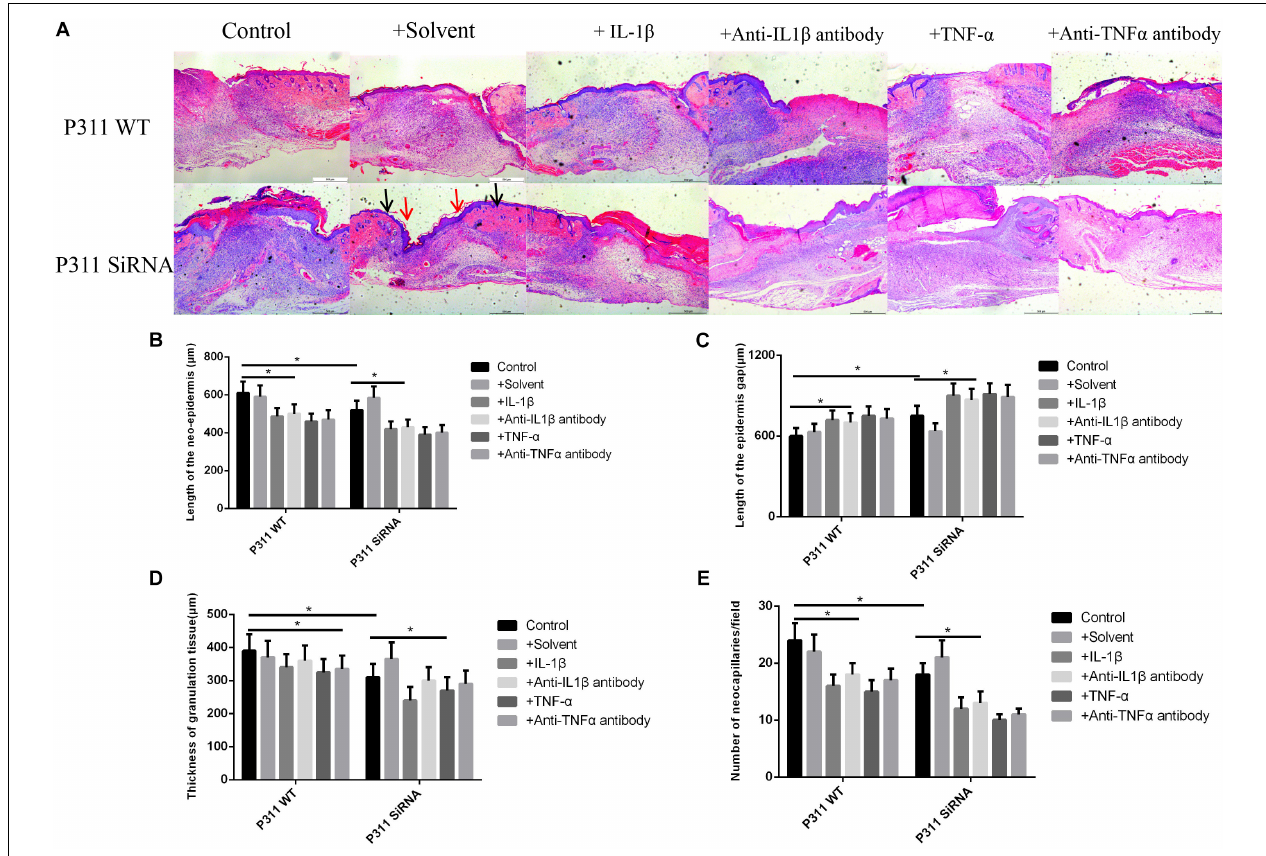
FIGURE 7 | Effect of various stimulus factors on neonatal epithelial length, granulation tissue thickness, and number of blood vessels. Mean ± standard deviation (SD) denote the experimental results; * indicates P < 0.05. (A) Representative histological images of the length of neonatal epithelium under different stimulus factors in P311 WT and P311 siRNA groups. (B) Neonatal epithelium length measurement. (C) Epidermis gap length measurement. (D) Measurement of granulation tissue thickness. (E) Measurement of the number of